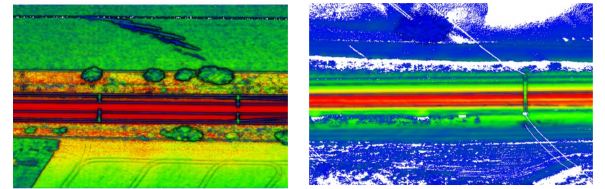
Figure 1. Top view of railway LIDAR point clouds using: airborne capture (left), railborne capture (right), colorized by relative local density (low-medium-high / blue-green-red) PCSS represents a first step towards optimizing